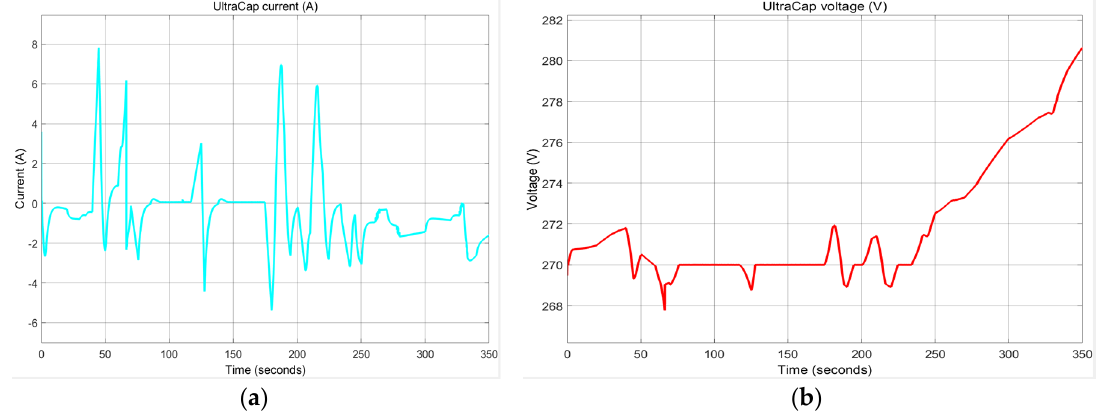
Figure A11. SC specific variables. ( a ) SC current variation; ( b ) SC voltage.